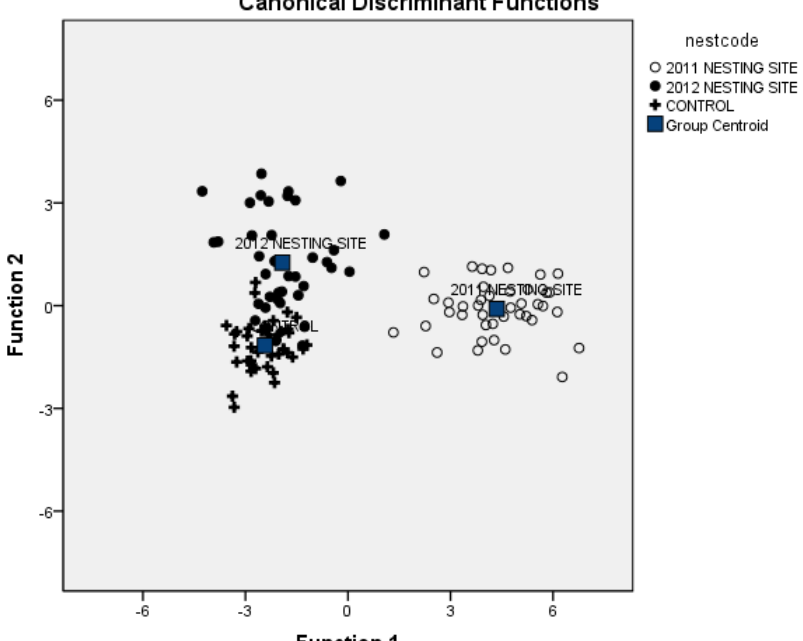
Figure 2. Canonical discriminant functions and their success in separating the three nesting sites (2011 nest, 2012 nest and control) for the significant soil variables used by Socotra Cormorants in the UAE.